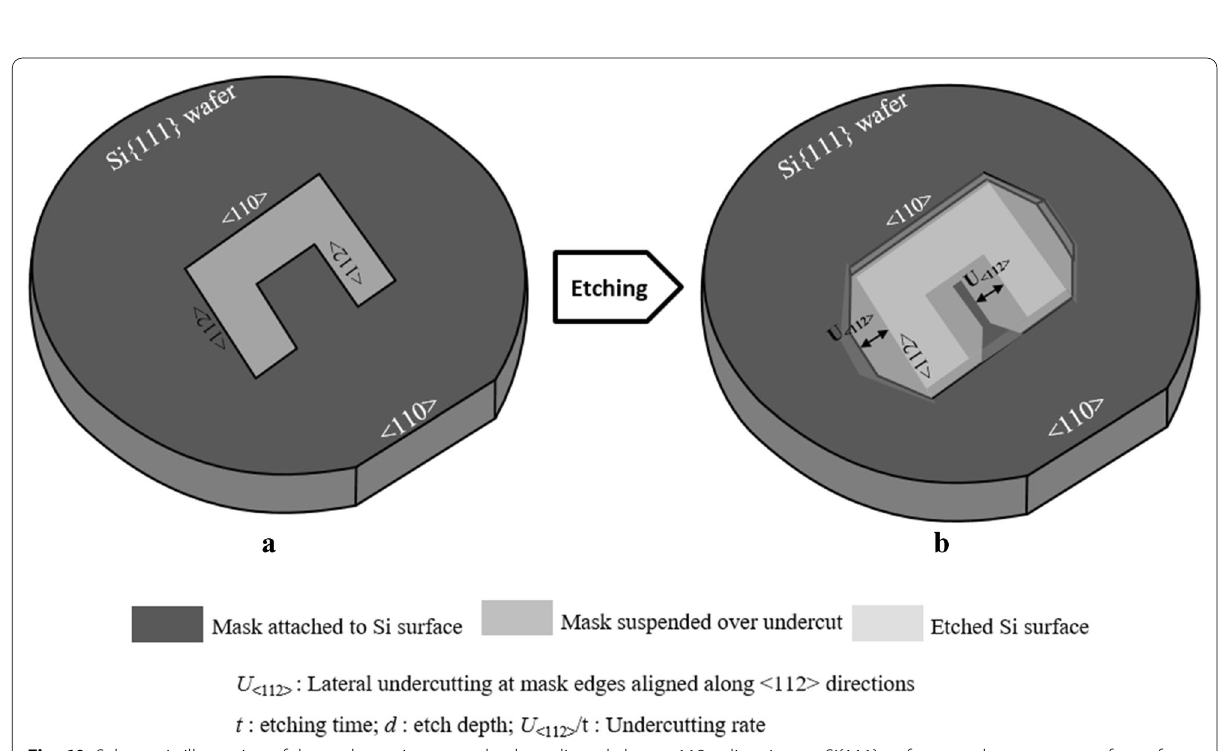
Fig. 60 Schematic illustration of the undercutting at mask edges aligned along < 112 > direction on Si{111} wafer: a mask pattern on wafer surface, b etched profile after wet anisotropic